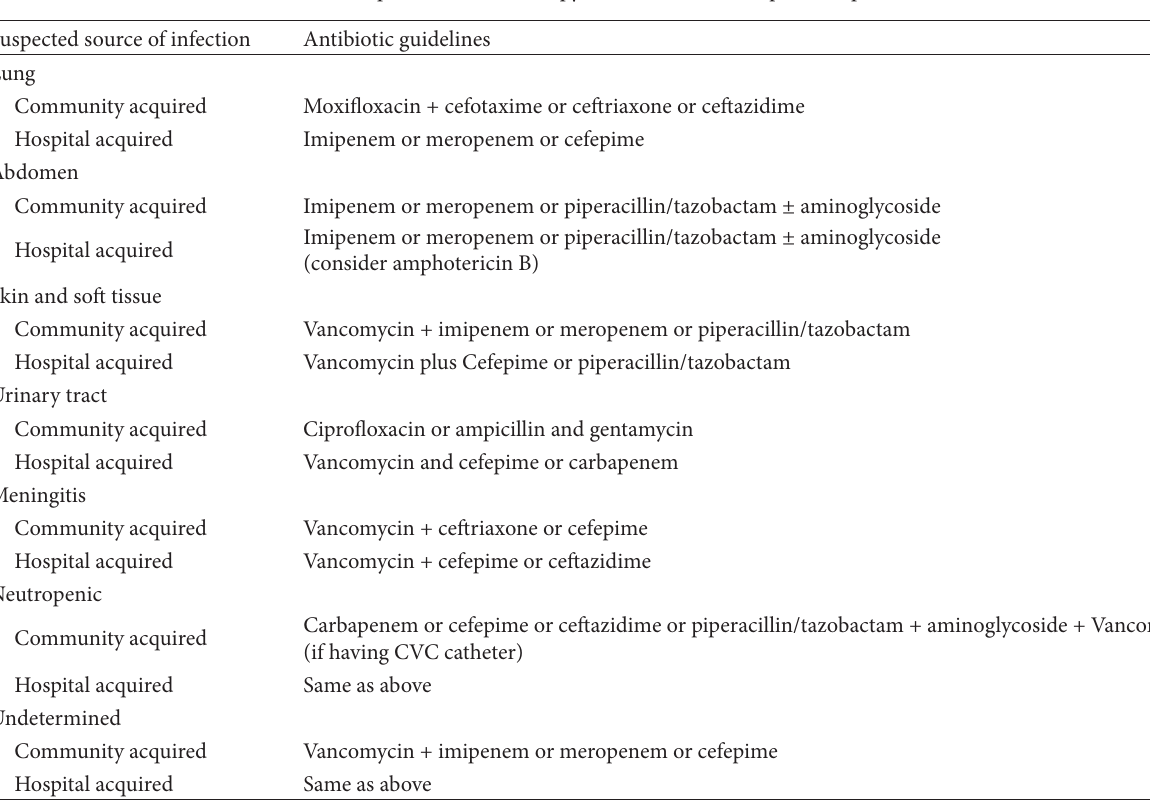
Table 1: Empiric antibiotic therapy for cases of severe sepsis or septic